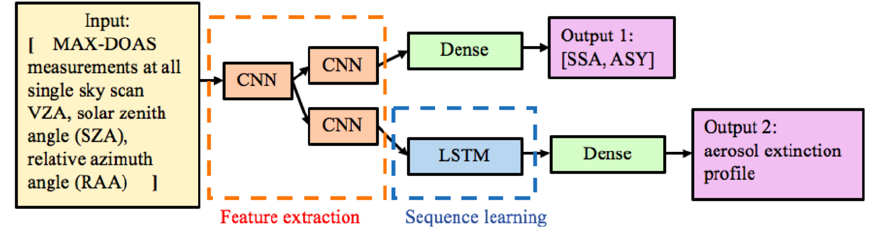
Figure 6. Schematics of the multi-output sequence-to-sequence model for deriving aerosol optical properties from MAX-DOAS measure- ments.